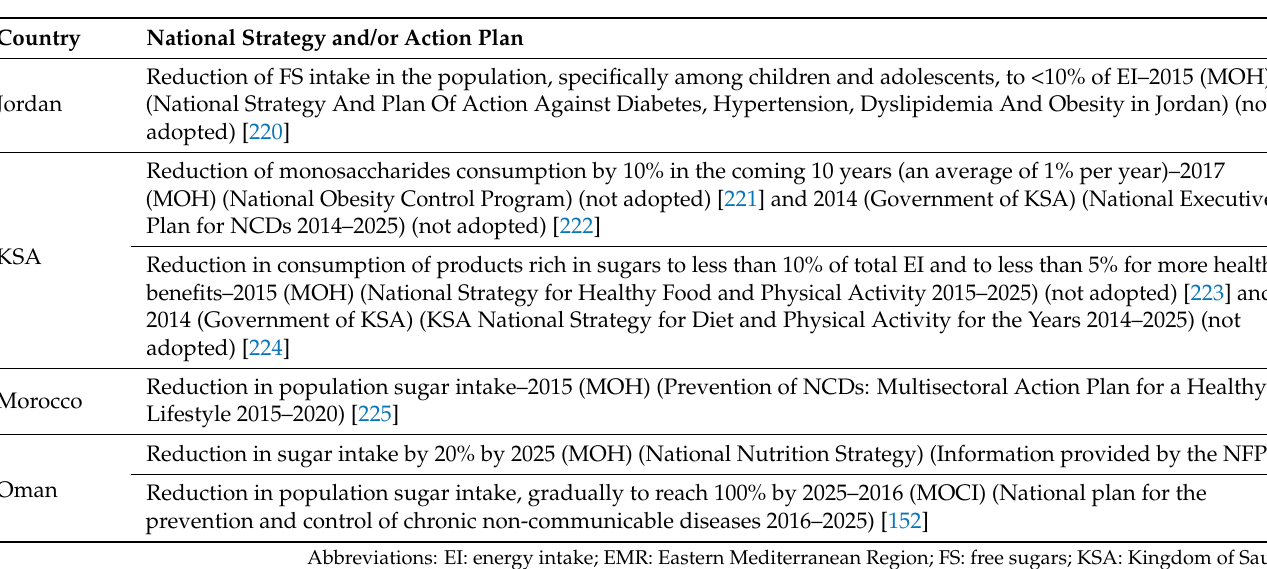
Table 3. National sugar reduction strategies or action plans identified in the EMR